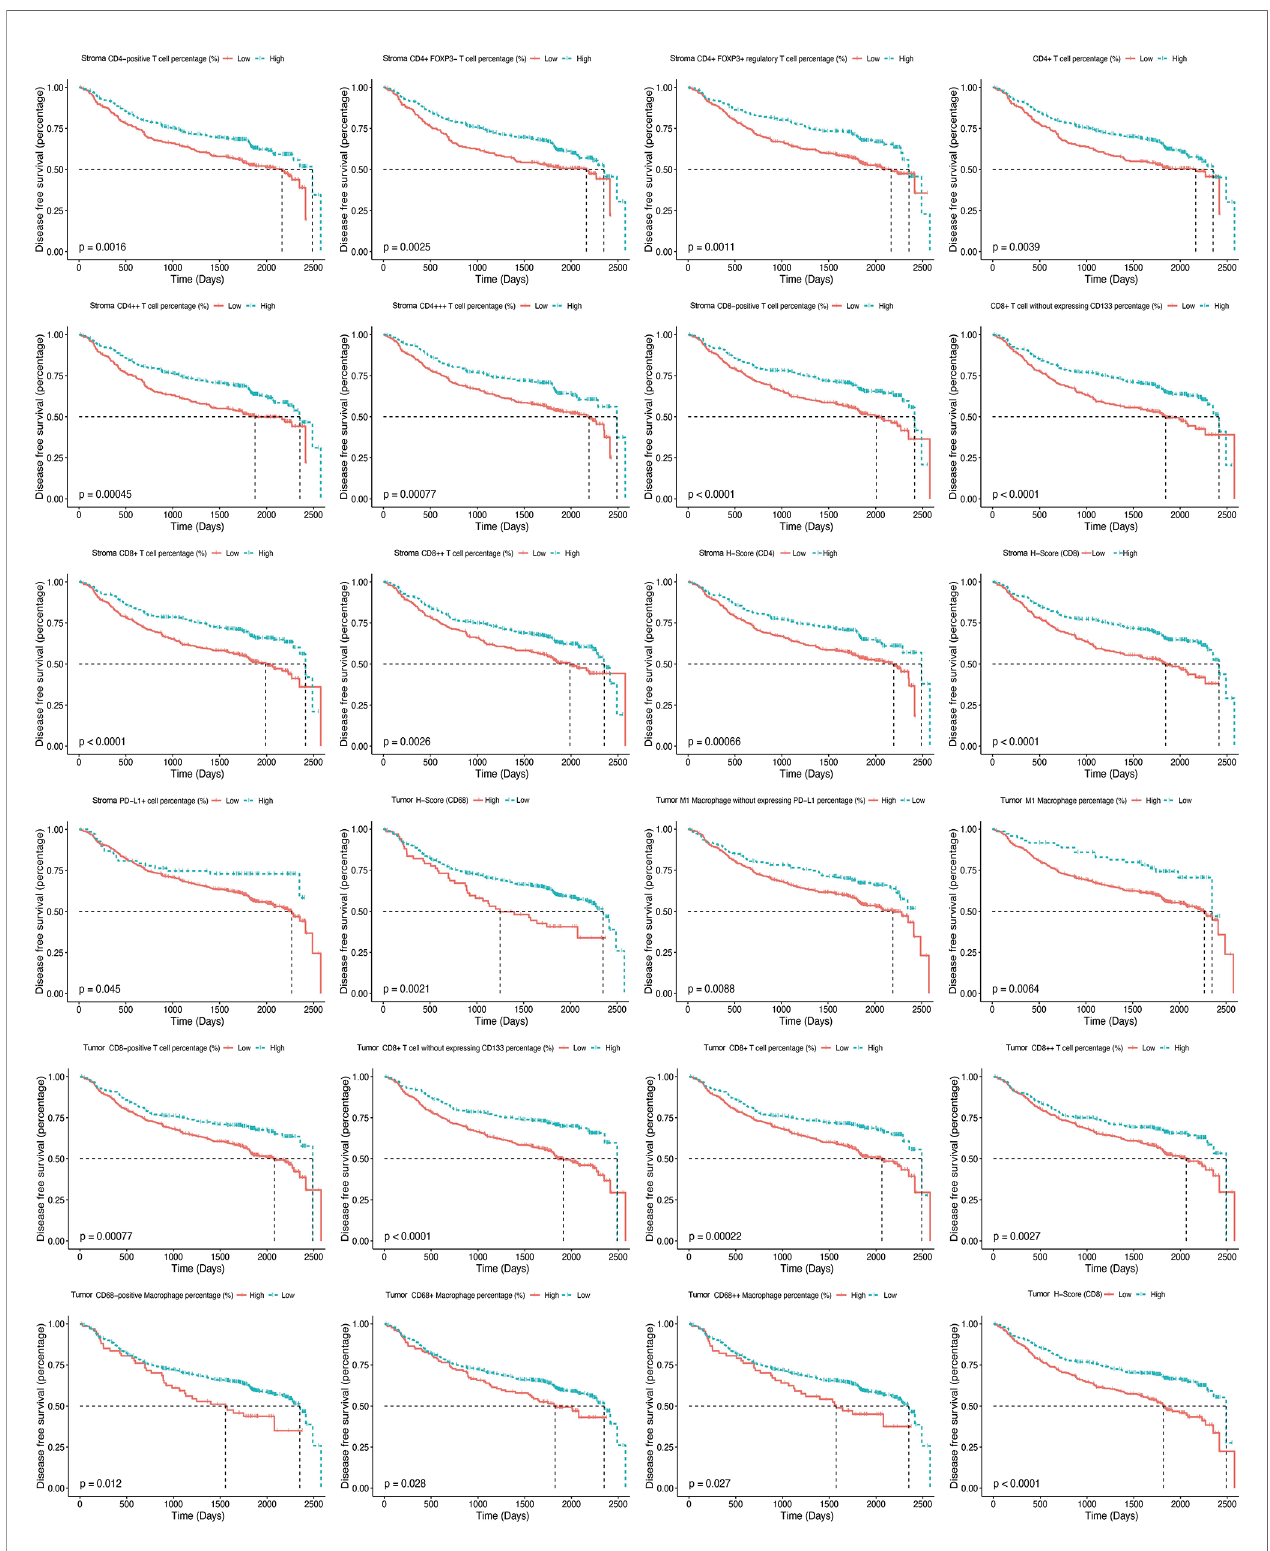
FIGURE 6 | Kaplan – Meier curves illustrate the associations between the expression levels of immune biomarkers (high vs . low) within the tumor nest and tumor stroma and the disease-free survival of non-small cell lung